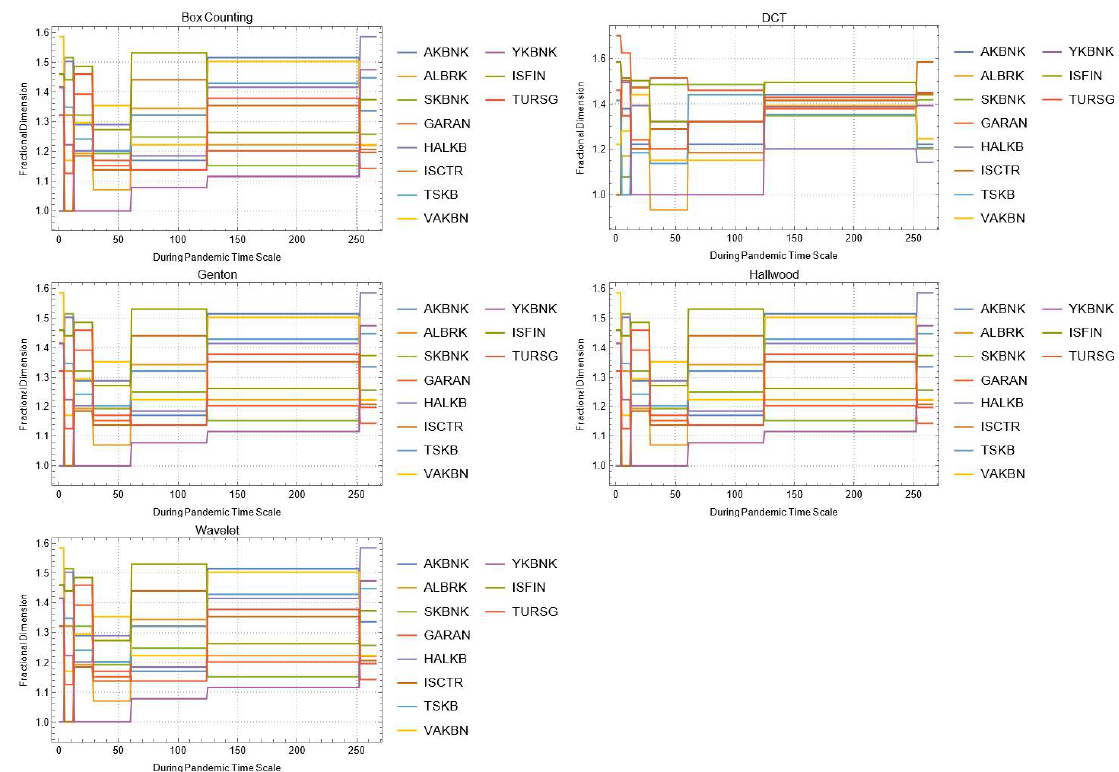
Figure A10. Daily changes of fractal dimensions during the pandemic (financial services).